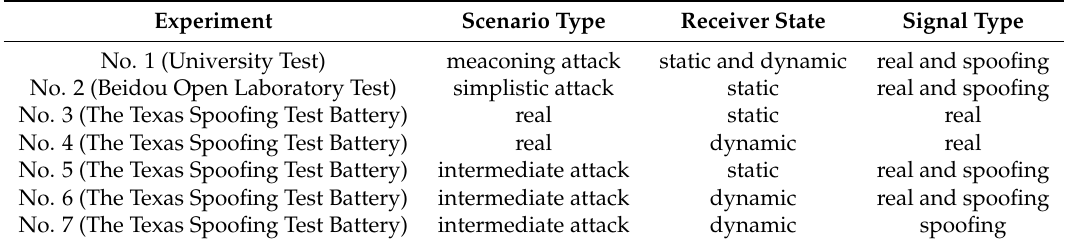
Table 1. The characteristics of different